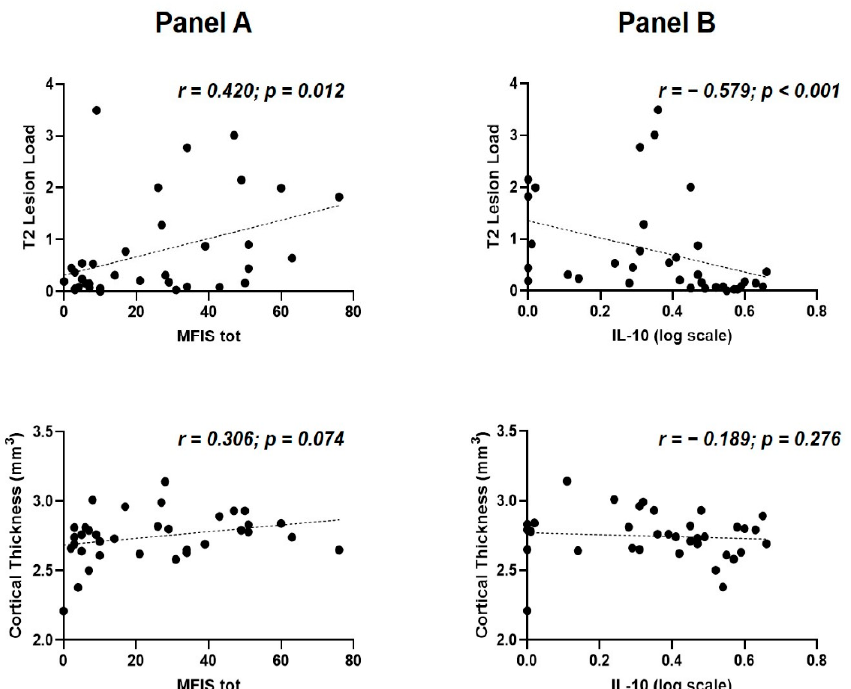
Figure 2. Fatigue, IL-10 and structural MRI measures at the time of MS diagnosis. ( A ) correlations between fatigue, T2 lesion load (upper) and cortical thickness (lower); ( B ) correlations between IL-10 concentrations, T2 lesion load (upper) and cortical thickness (lower). Abbreviations: IL, interleukin; MFIS tot, Modified Fatigue Impact Scale total score; MS, multiple